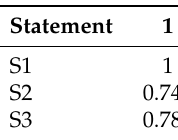
Table 3. Seamless Transition Scale (STS) statements